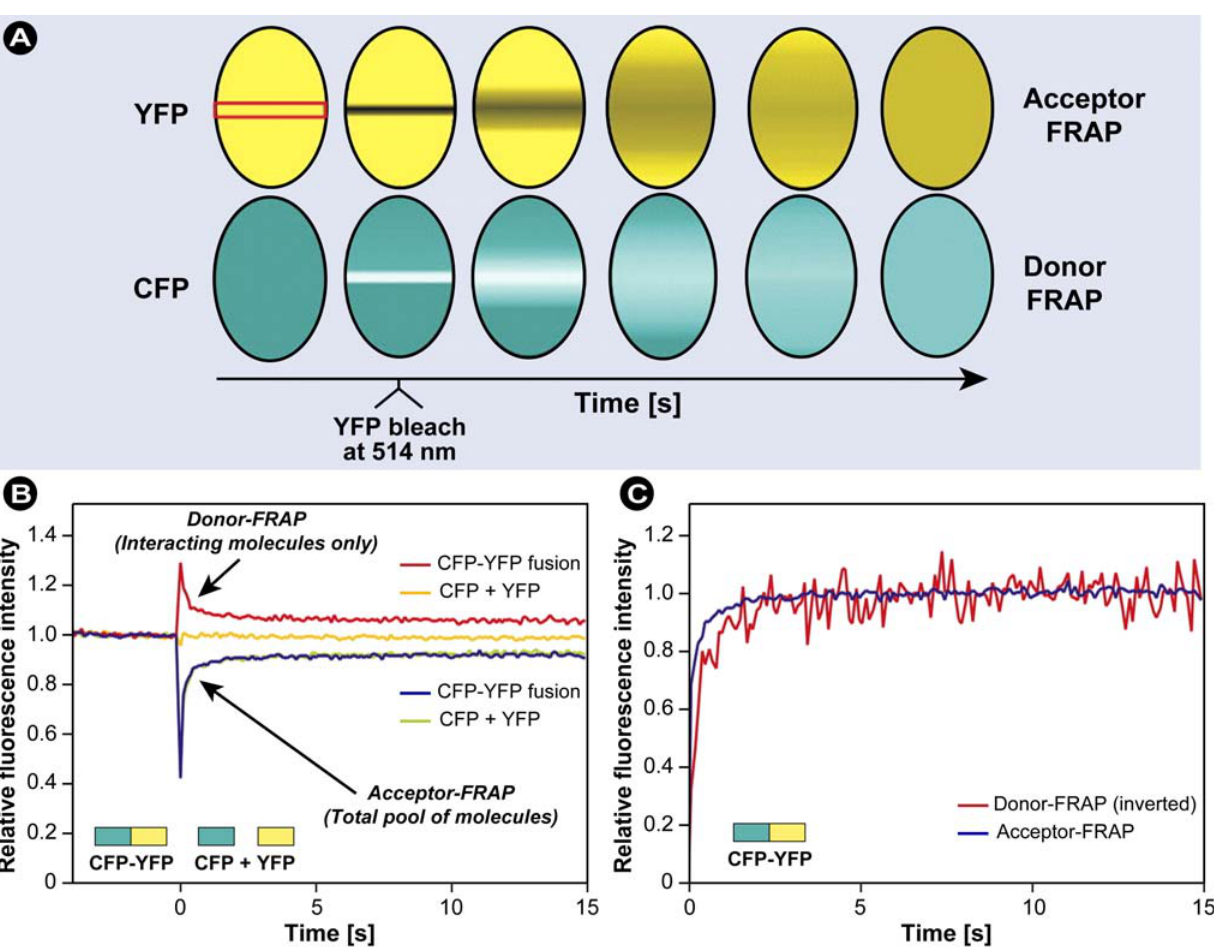
Figure 25. Simultaneous FRAP and FRET measurements to separately determine the mobility of interacting and noninteracting CFP- and YFP-tagged proteins in a single cell nucleus. ( A ) Schematic representation of the method. A 100 ms high-intensity bleach pulse at 514 nm is applied to irreversibly photobleach YFPs in a narrow strip spanning the nucleus. Redistribution of YFP and CFP fluorescence is recorded at 100 ms intervals at 458 nm. Donor (CFP) emission (increased because of unquenching as a result of acceptor [YFP] bleaching) represents the mobility of interacting molecules only (donor-FRAP). Acceptor emission represents the total pool of YFP-tagged molecules irrespective of interaction (acceptor-FRAP). ( B ) Graph showing CFP and YFP fluorescence intensities in the bleached strip plotted against time. Experiments were performed in Hep3B cells expressing CFP-YFP fusions (red line indicates CFP fluorescence [donor-FRAP], and blue line indicates YFP fluorescence [acceptor-FRAP]), or in Hep3B cells expressing separate CFPs and YFPs (yellow line indicates CFP, and green line indicates YFP; n = 30). ( C ) Inverted donor-FRAP (red line) and acceptor-FRAP (blue line) plotted against time, showing = (I − I )/(I − I ), similar kinetics. The curves were normalized by calculating I norm raw 0 final 0 and I are the fluorescence intensities immediately after the bleach and after where I 0 final complete recovery,